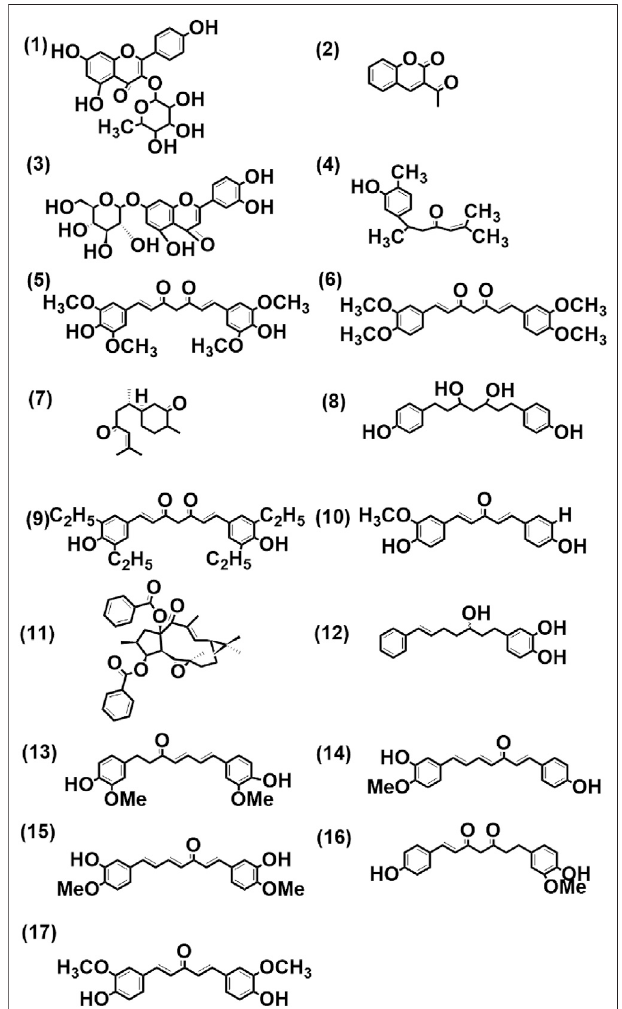
FIGURE 4 | Structure of few selected cultivar-speci fi c (panels 3, 5 – 11 corresponding to serial numbers 2, 3 – 9 of Table 6 ); detected in more than one cultivar (panels 1 – 2, 4, 12 corresponding to serial numbers 4 – 5, 6, 7 of Table 7 ) and common (panels 13, 14 – 15, 16, and 17 corresponding to serial numbers 10, 5 – 6, 15, and 1, respectively, of Table 8 ) compounds already reported from genus Curcuma inmethanolicextract from rhizomesby LCMS analysis of seven cultivars of Curcuma spp.: fi ve of Curcuma longa L. (cvs. Alleppey Supreme, Duggirala Red, Prathibha, Salem, and Suguna) and two of C. aromatica Salisb. (cvs. Kasturi Araku and Kasturi Avidi). (1) Kaempferol-3-rhamnoside, (2) 3-acetyl coumarin, (3) luteolin-7-O-glucoside, (4) turmeronol, (5) 1,7-bis(4-hydroxy-3,5-dimethoxyphenyl)-1,6-heptadiene- 3,5-dione, (6) 1,7-bis(3,4-dimethoxyphenyl)-1,6-heptadiene-3,5-dione, (7) (6S)-2-methyl-6-[(1R,5S)-(4-methene-5-hydroxyl-2-cyclohexen)-2-hepten-4- one, (8) 1,7-bis(4-hydroxyphenyl)-3,5-heptanediol, (9) 1,7-bis(3,5-diethyl-4- hydroxyphenyl)-1,6-heptadiene-3,5-dione, (10) 1-(4-hydroxy-3- methoxyphenyl)-5-(4-hydroxyphenyl)-1,4-pentadiene-3-one, (11) heptene, (13) 1-(3,4-dihydroxyphenyl)-7-(4-hydroxy-3-methoxyphenyl)- hepta-1,6-diene-3,5-dione, (14) 1-(4-hydroxyphenyl)-7-(4-hydroxy-3- (4-hydroxy-3-methoxyphenyl)-, (17) 1,5-bis(4-hydroxy-3-methoxyphenyl)- 1,4-pentadien-3-one.